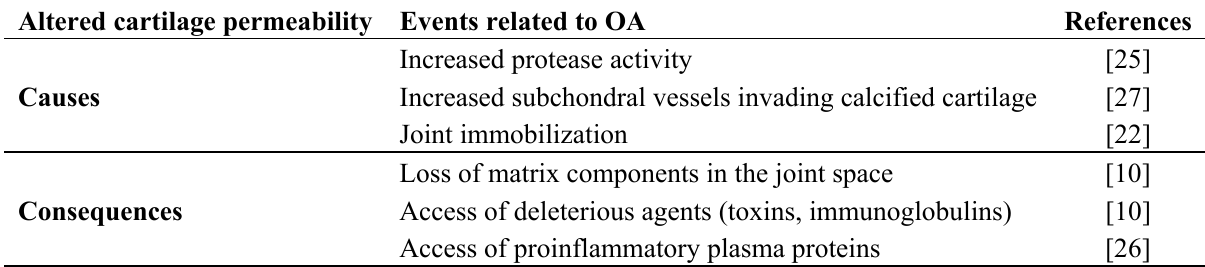
Table 1. Altered cartilage permeability during osteoarthritis